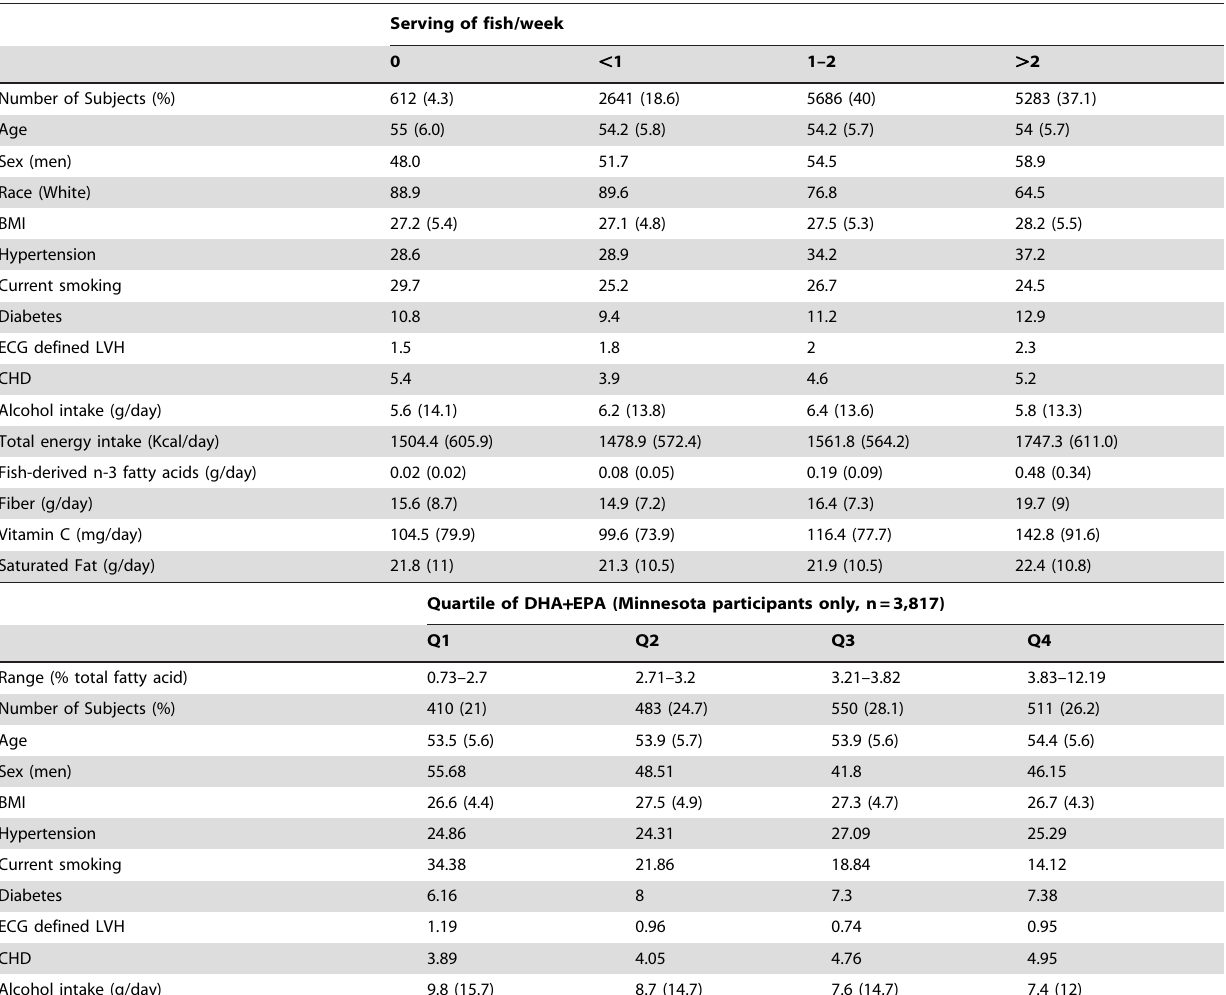
Table 1. Baseline characteristics of ARIC participants (n= 14,222), 1987–1989.